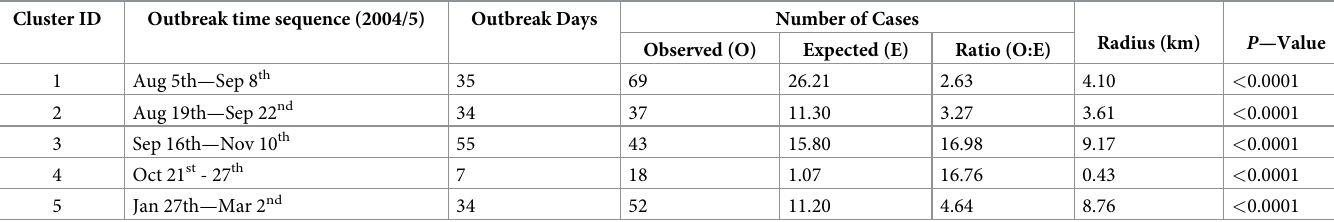
Table 2. Temporal characteristics of case clusters in Hippopotamus anthrax outbreaks of 2004/5. Cluster